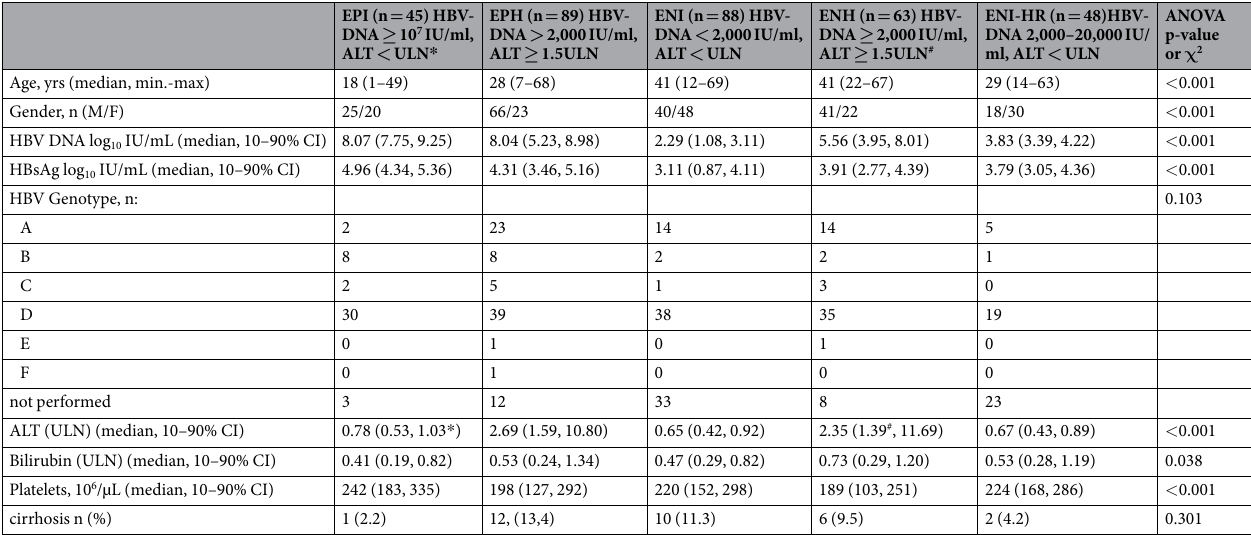
Table 1. Baseline characteristics and factors univariately differentiating between patients in different phases of chronic HBV infection based on ANOVA (continuous values) and Chi-Square analysis (discrete values). * In EPI group patients with ALT < 1.5ULN were accepted if no inflammation in liver biopsy was observed. # In ENH group patients with ALT 1.0–1.5 ULN were accepted if significant inflammation (A1 > 2) in liver biopsy was